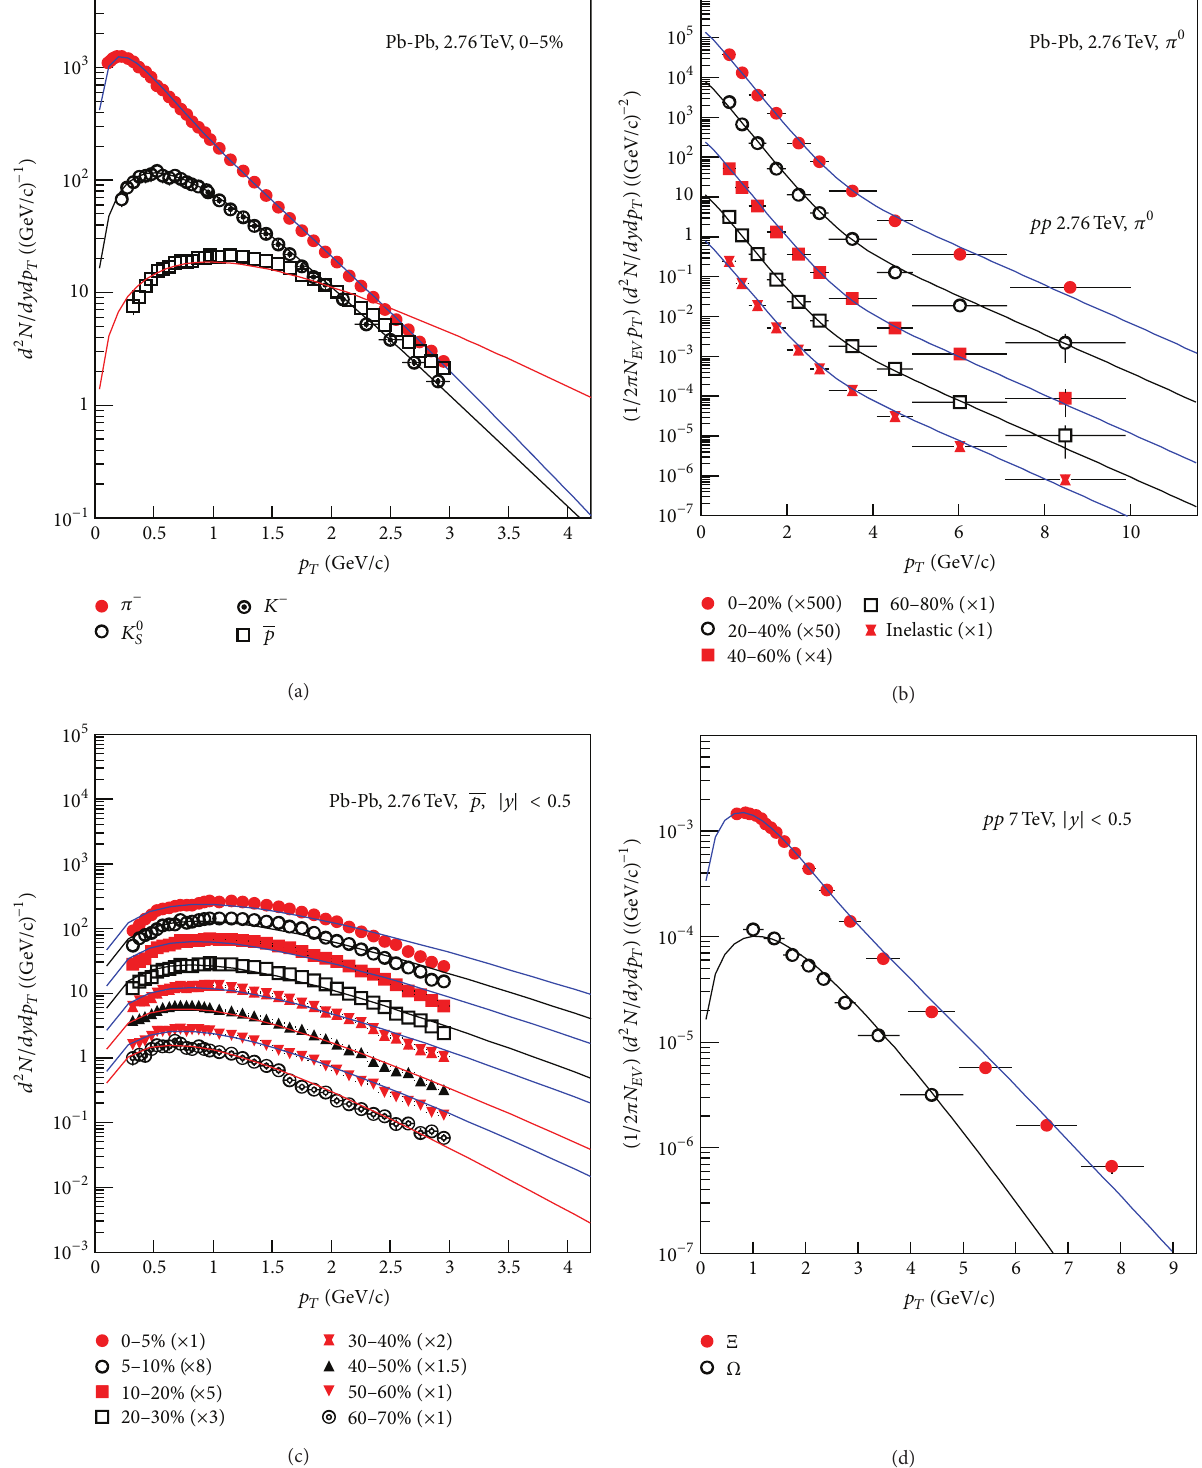
Figure 9: The transverse momentum distributions of (a) 𝜋 − , 𝐾 0 𝑆 + 𝐾 − , and 𝑝 , (b) 𝜋 0 , (c) 𝑝 , and (d) Ξ and Ω produced in Pb-Pb collisions at √𝑠 𝑁𝑁 = 2.76 TeV ((a), (b), and (c)) and pp collision at √𝑠 = 2.76 and 7TeV ((b) and (d)) with different y ranges, centrality classes, and magnifications are shown in the figure. The symbols represent the experimental data of the ALICE Collaboration [35–38] and the curves are our results calculated by the Boltzmann or two-component Boltzmann